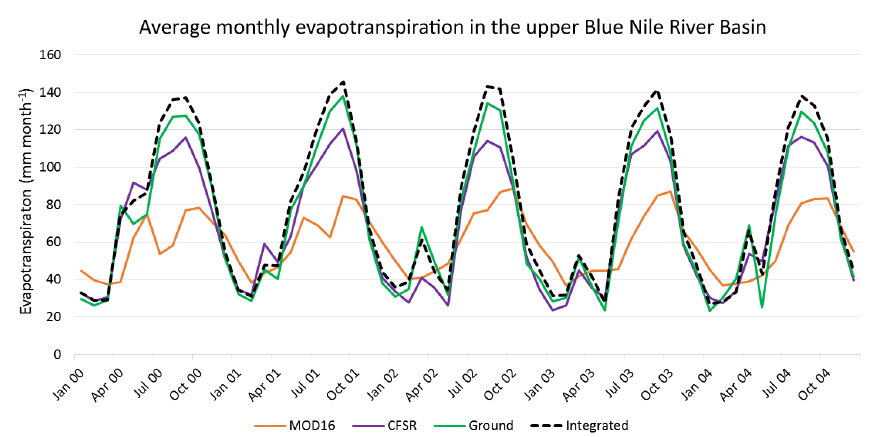
Figure 11. Average monthly evapotranspiration analysis using SWAT87 and the Hargreaves method, with R 2 and NS values of the integrated dataset: 0.63, − 2.32; ground dataset: 0.60, − 1.32; and CFSR dataset: 0.63, − 1.20, respectively, compared to the MOD16 data.